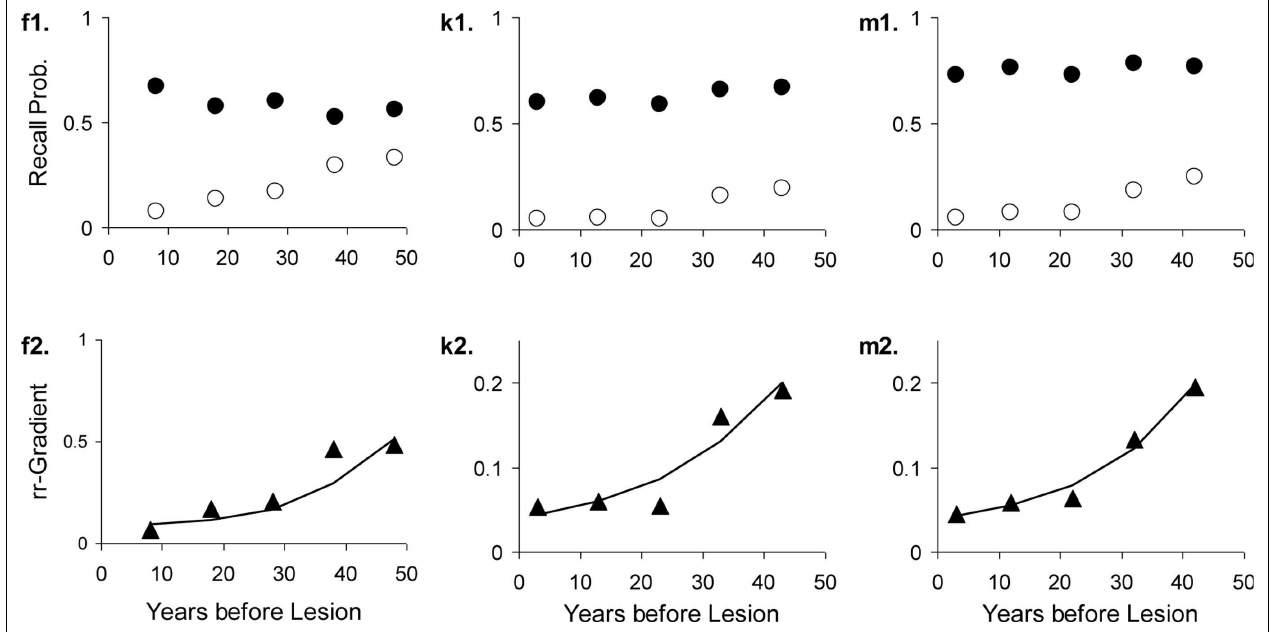
FIGURE 11 |Three studies withAlzheimer’s Dementia patients and matched controls. The letters with each panel correspond to those in Table 3 . See Figure 10 for further explanation.